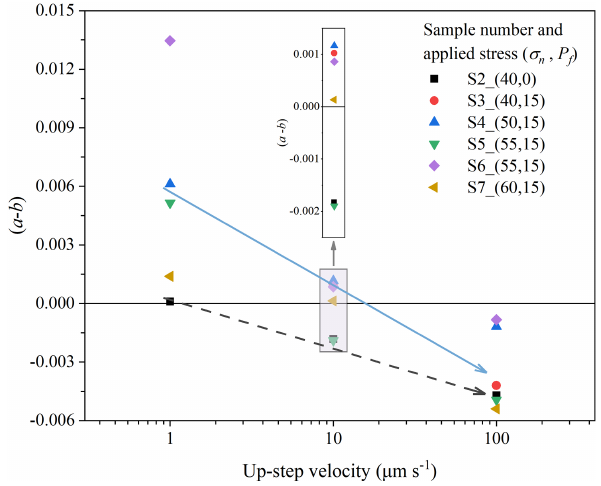
Figure 12. The (a − b) values obtained from experiments S2–S7 versus up-step velocity, showing a transition from velocity strength- ening to velocity